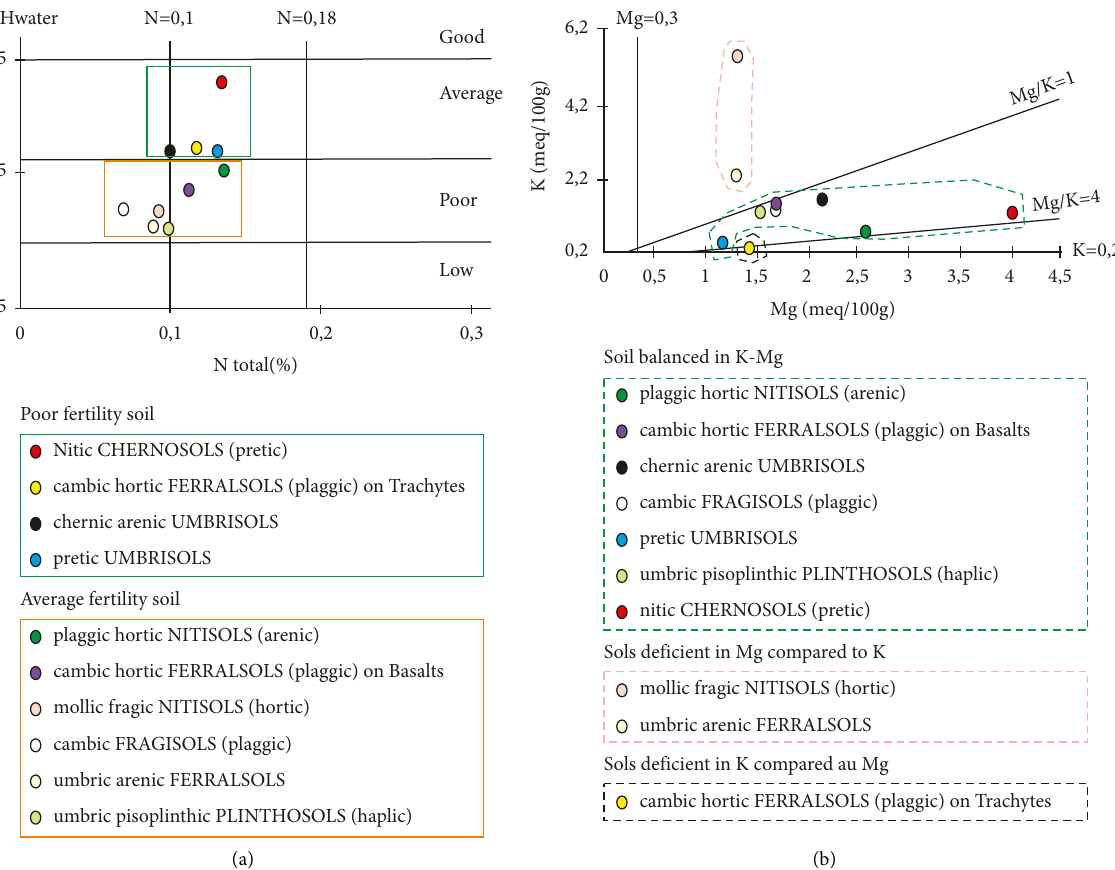
Figure 6: Classification of Foumban soils in function of the fertility and K-Mg. (a) N-pH balance [32] and (b) figure: K-Mg balance after Dabin